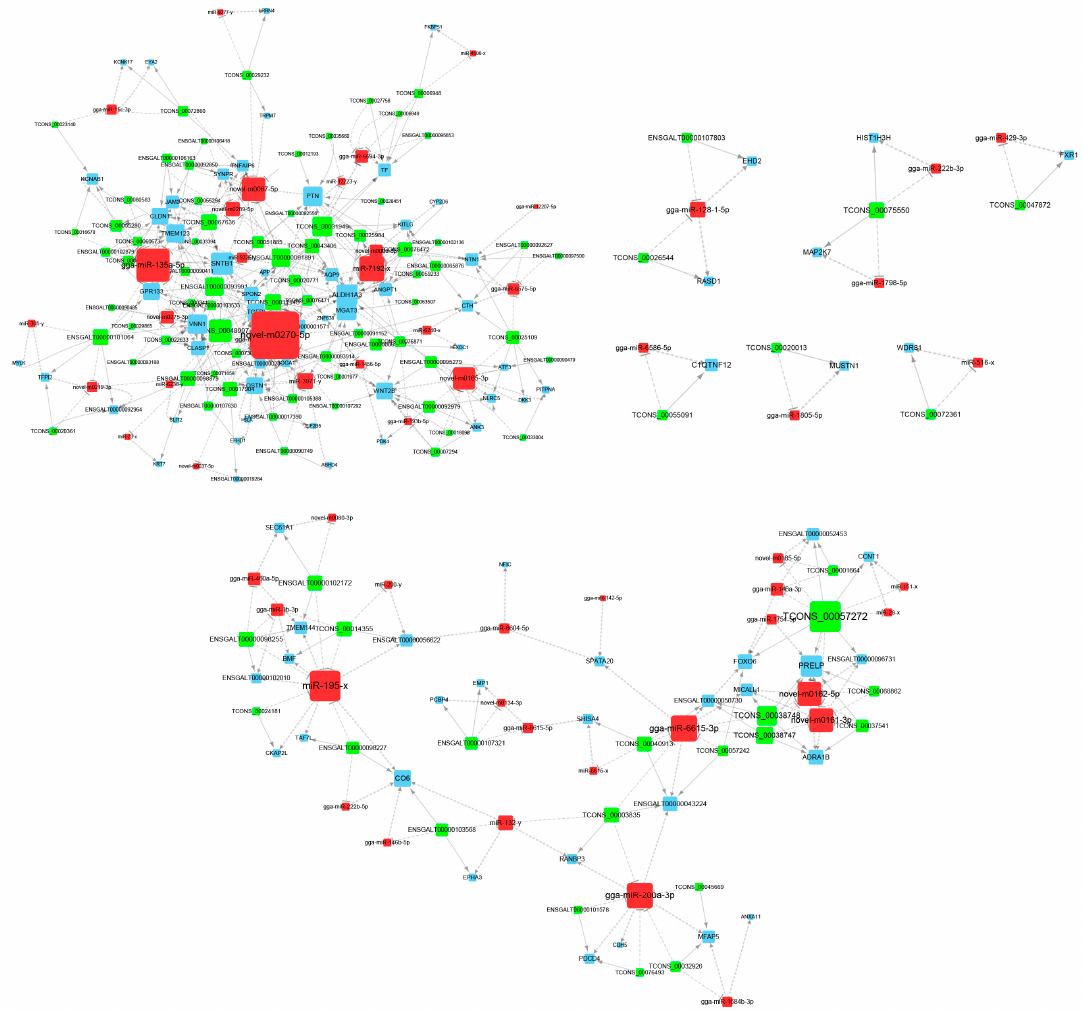
Figure 3. Visualization of the lncRNA-miRNA-mRNA network. Green nodes indicate lncRNAs, red nodes indicate miRNAs, and blue nodes indicate mRNAs, respectively. Node size is proportional to the connection degree. Connection degree shows the number of connected nodes with the individual node. The higher the degree of a node, the more important the node in the network. Hub genes are the nodes with higher degree i.e., nodes with more connections (degree > 4.9).